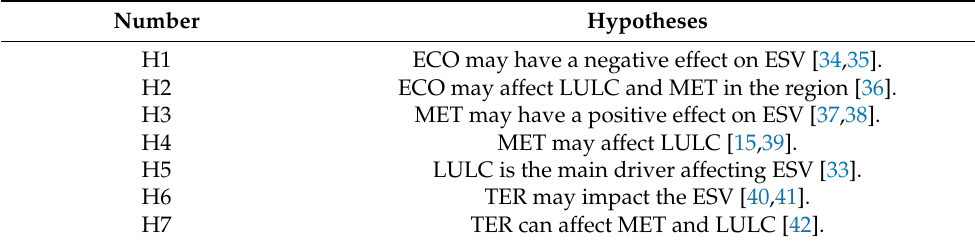
Table 5. Hypotheses in structural equation